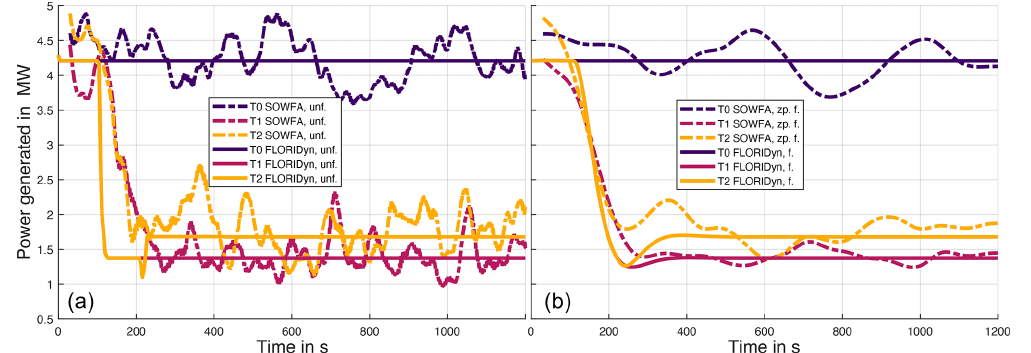
Figure 6. Wind farm start-up and steady-state comparison of the power generated in SOWFA and in FLORIDyn. The unfiltered data are plotted in panel (a) , filtered data are plotted in panel (b) . The SOWFA data are filtered with a zero-phase (noncausal) low-pass filter and FLORIDyn with a causal low-pass